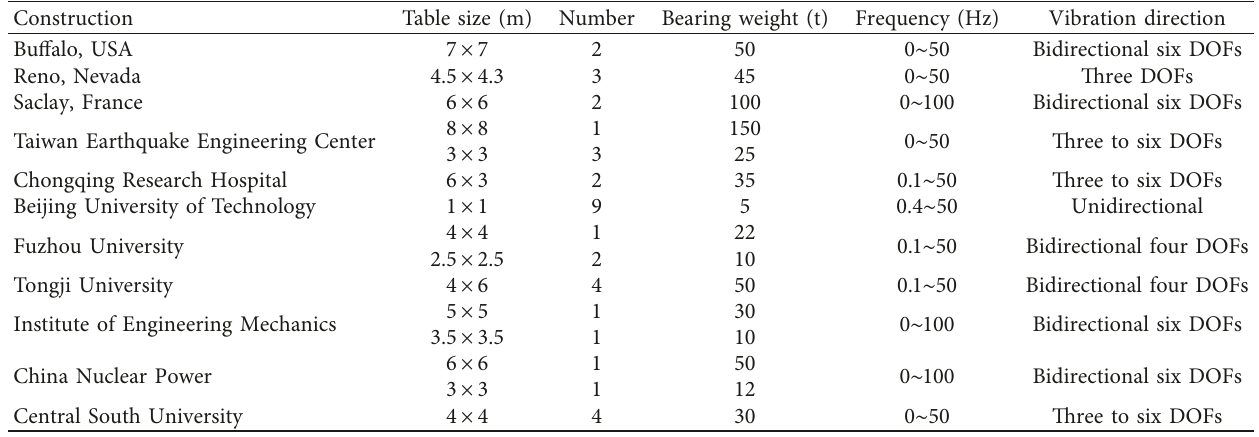
Table 3: Multiple shaking table construction.